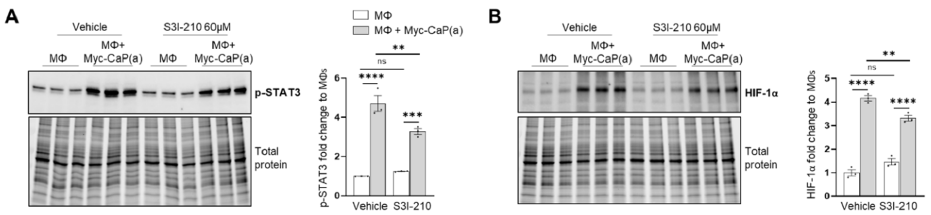
Figure A2. STAT3 inhibition in FVB/NJ bone marrow macrophage efferocytosis of apoptotic pros- tate cancer Myc-CaP cells.BM macrophages (M Φ ) were isolated from 4 wk old FVB/NJ mice and co- cultured with apoptotic Myc-CaP(a) cells for 16–18 h ( n = 3). ( A , B ) Western blot of protein lysates from efferocytic and control BM macrophages treated with 60 µM S3I-210 (p-STAT3 inhibitor) using p-STAT3 and HIF-1 α antibodies. Plotted data are shown as mean ± SEM, ** p < 0.01, *** p < 0.001, **** p < 0.0001, ns = not significant (ordinary one-way ANOVA; Tukey’s multiple comparison test).